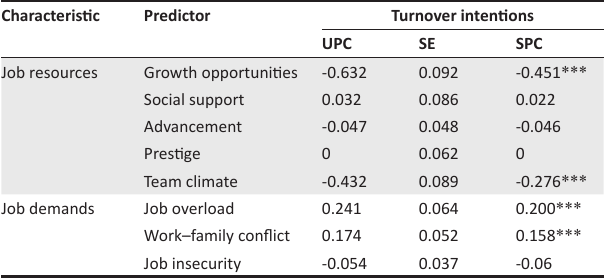
TABLE 3: Direct effects of job demand and job resources on turnover intentions ( n =